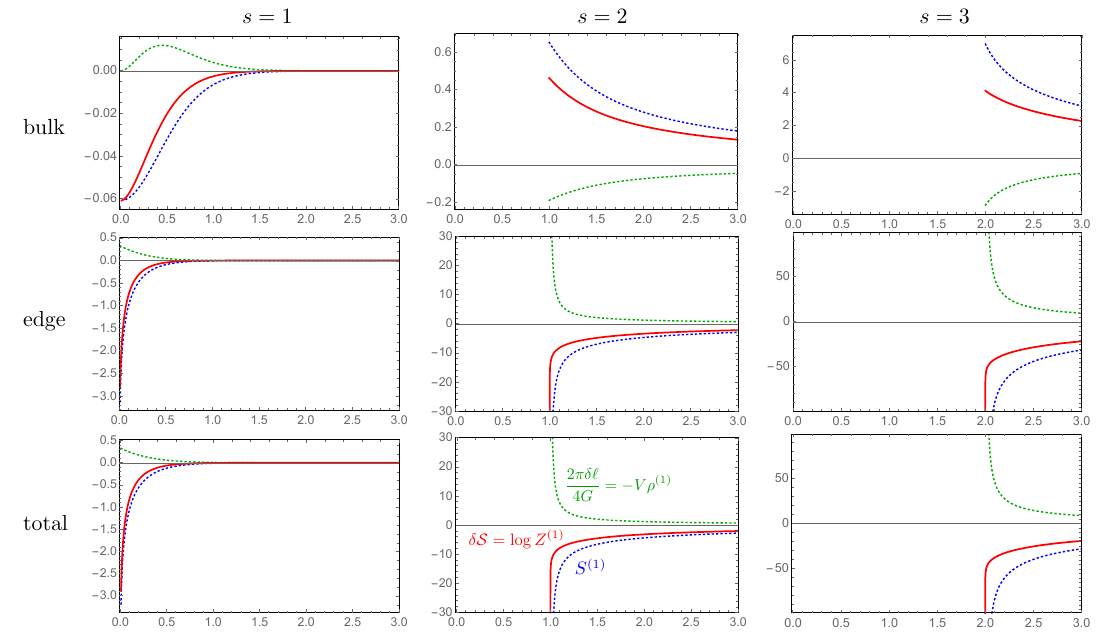
Figure 22 . Contributions to the dS 3 entropy from massive spin s = 1 , 2 , 3 fields, as a function of m‘ 0 , with coloring as in figure 21. Singularities = Higuchi bound, as discussed under